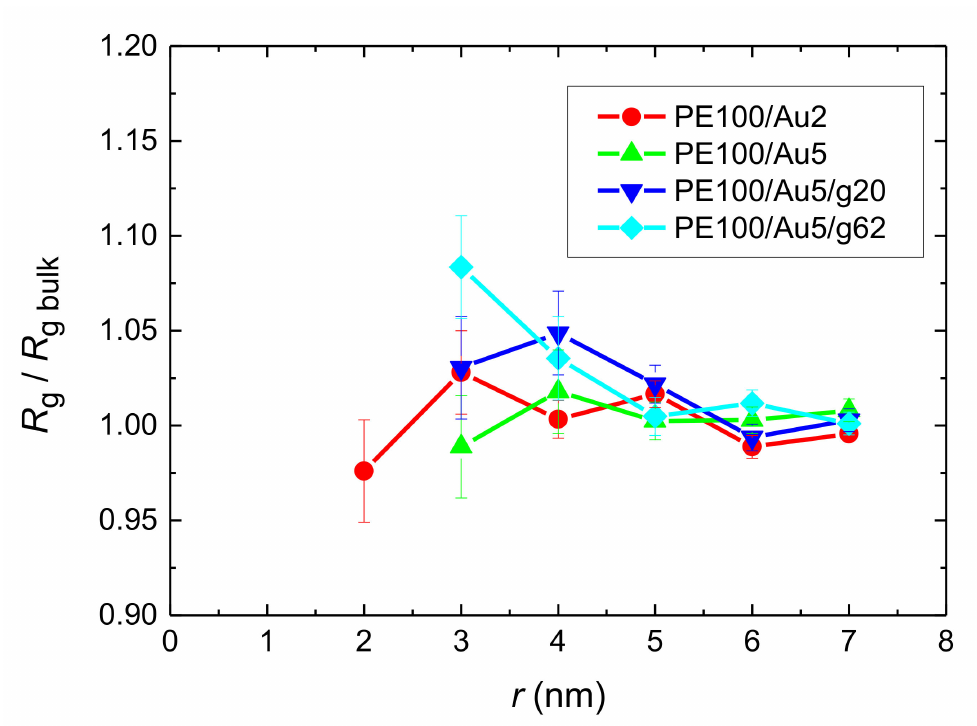
Figure A5. Radius of gyration of PE chains, scaled with its bulk value ( R g / R g bulk ) as a function of dis- tance, r , from the center of the gold NP. Data for the PE100, PE100/Au2, PE100/Au5, PE100/Au5/g20 and PE100/Au5/g62 systems are shown.